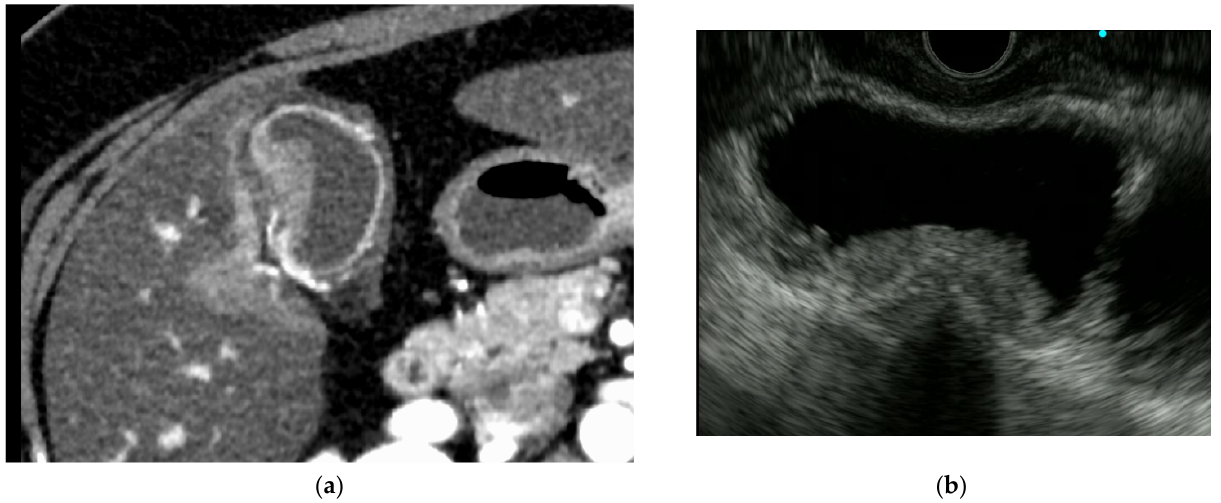
Figure 7. T3 gallbladder cancer. ( a ) Contrast-enhanced computed tomography: enhanced gallbladder mass in the body. ( b ) Endoscopic ultrasonography: hypoechoic tumor in the gallbladder with no hyperechoic outer layer.